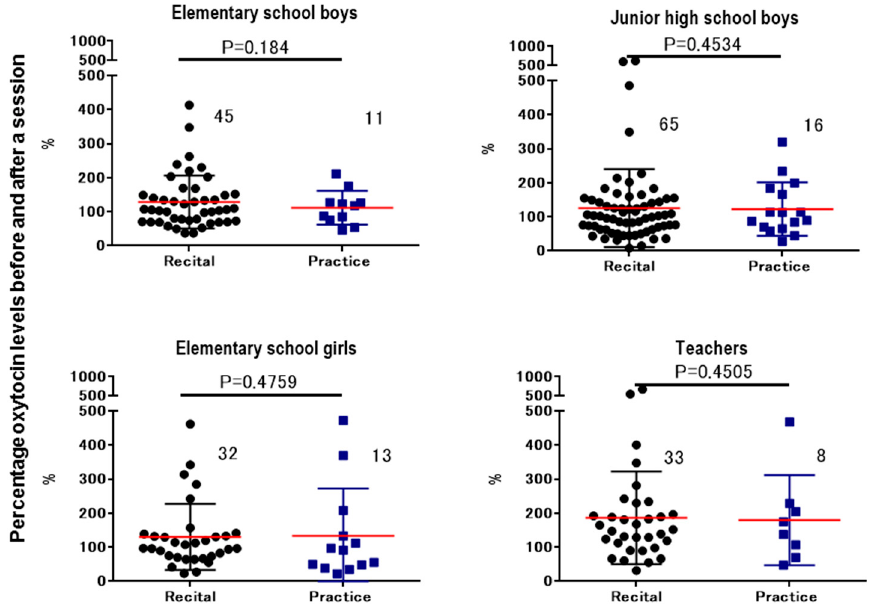
Figure 6. Changes in oxytocin levels before and after a single session. Percentage of oxytocin levels for the first (before) saliva over the second (after) saliva samples. Saliva was collected at recital and practice sessions from elementary school boys, junior high school boys, elementary school girls, and teachers. p values are for two-tailed Student’s t -tests.